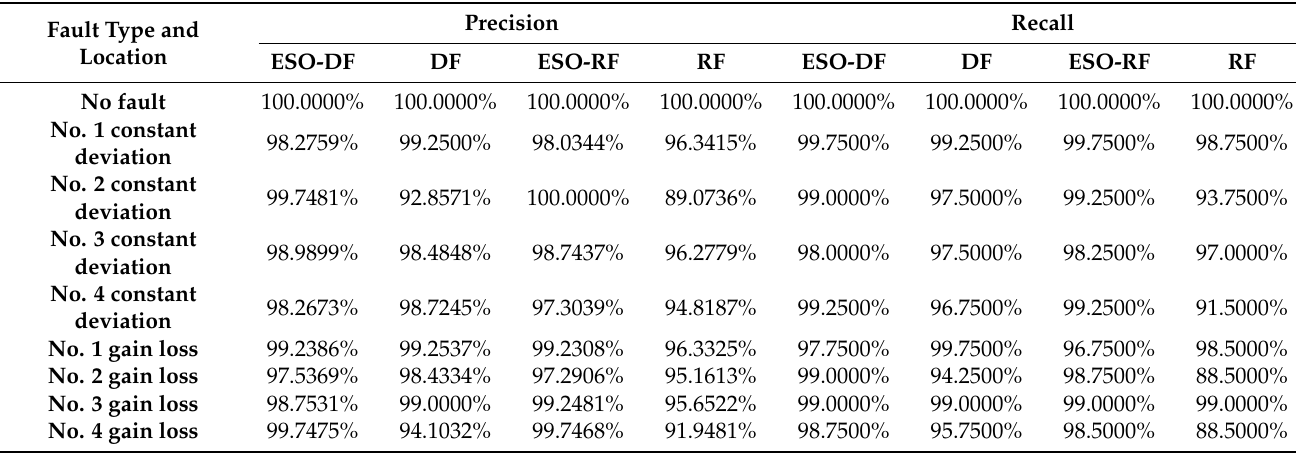
Table 4. Fault diagnosis and fault localization precision of different